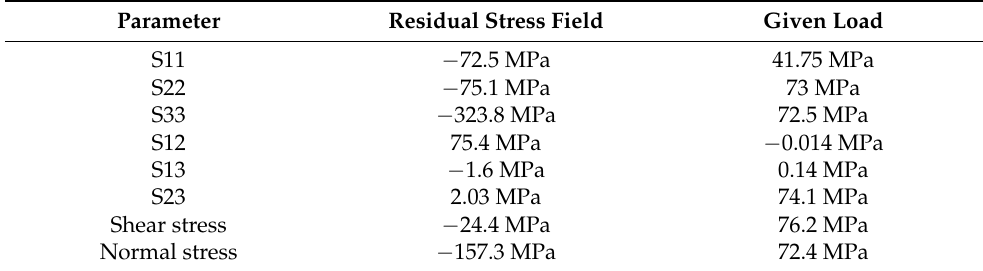
Table 3. Components of the stress sensor of crankshaft N0 from different sources. Parameter Residual Stress Field Given Load